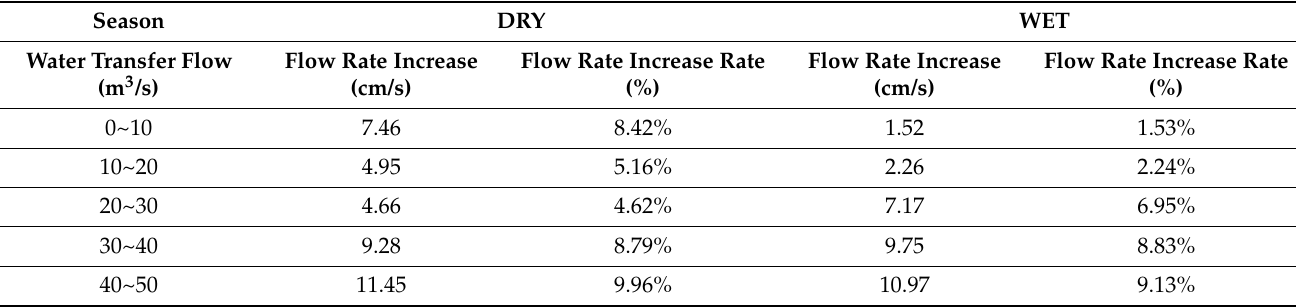
Table 1. Variation of river network flow rate in different water transfer